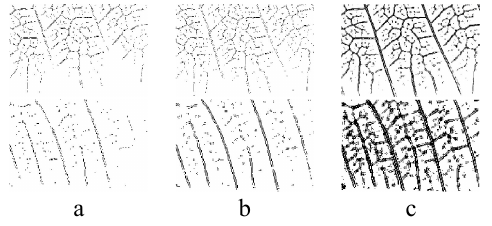
Figure. 5. Result in a) Roberts b) Sobel c) Adaptive